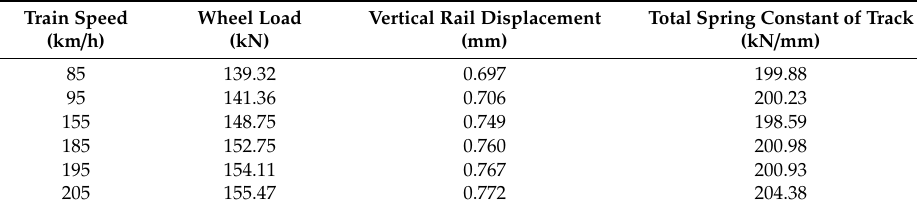
Table 10. Total spring constant of ballasted track (FEM).